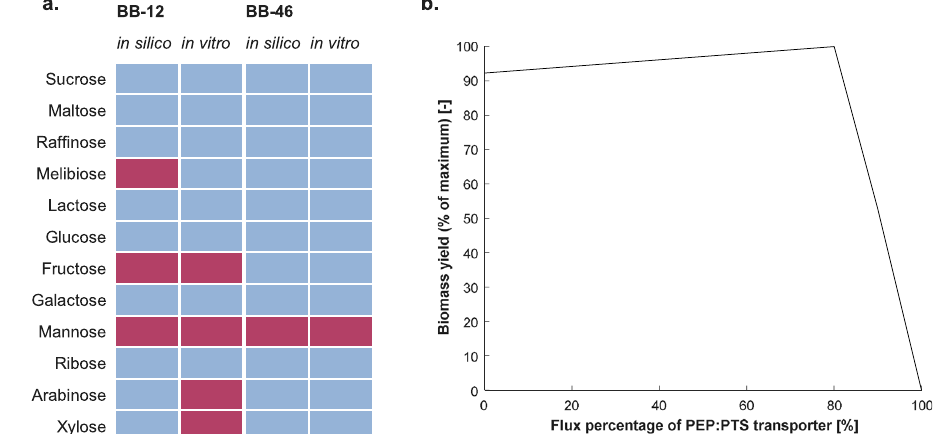
Fig. 7 Carbohydrate utilization by BB-12 and BB-46. a The capability of BB-12 and BB-46 to utilize 12 different carbohydrates was tested in batch fermentations in the newly formulated chemically de fi ned medium. Presence or absence of growth is indicated by blue and red colors, respectively. Knowledge gained from the experiments was incorporated into the models so that the model predictions agree with the in vitro results. b Effect of increasing glucose fl ux percentage through the PEP:PTS transport system on biomass yield of BB-46. 100%: fl ux only through the PEP:PTS transport system, 0%: transport only through the glucose proton symporter. The amino acid uptake rates were constrained to 1 mmol g CDW − 1 h − 1 .